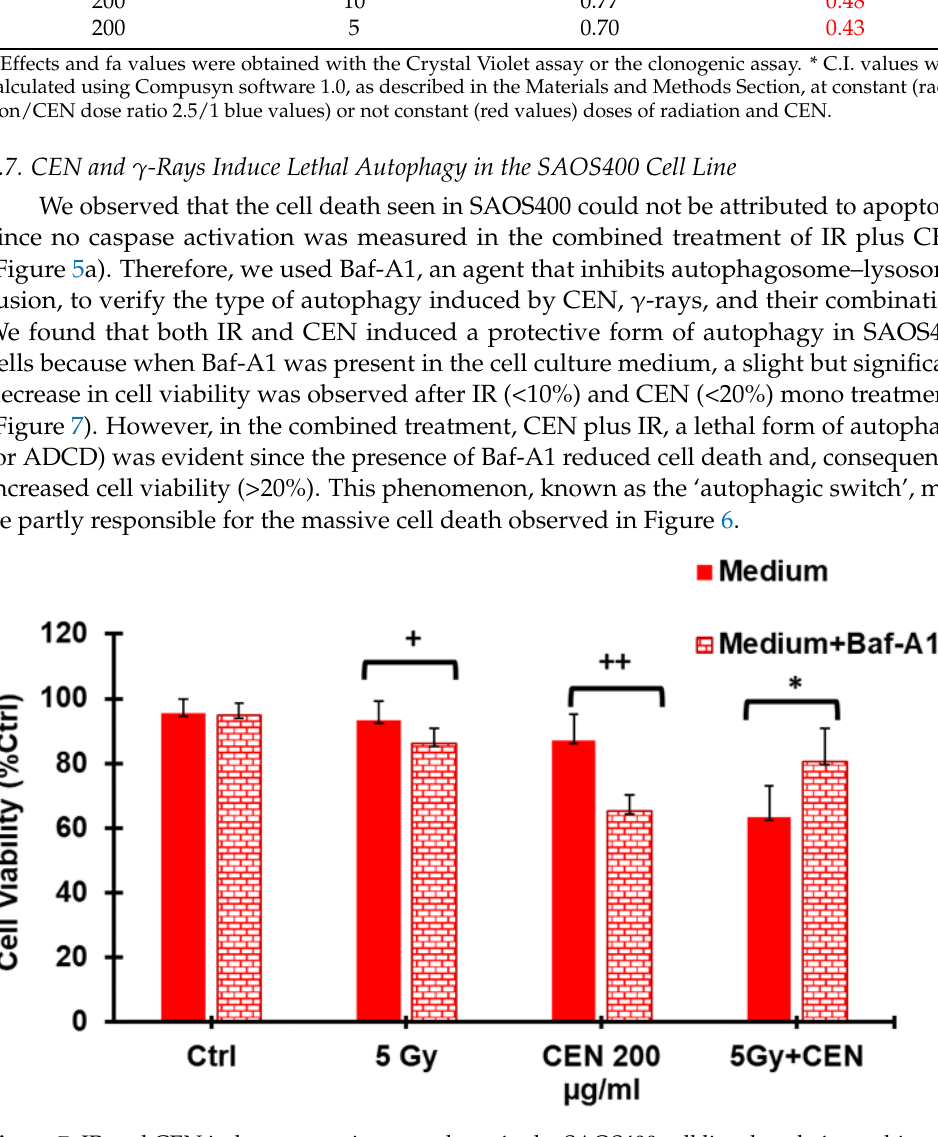
Table 1. Calculation of C.I. in the combined treatment of CEN plus IR. Figure 6. Irradiation and CEN synergistically induce cell death in the SAOS400 cell line. Panel ( a ): Cristal Violet Assay Crystal Violet assay in SAOS400 irradiated with 2.5 or 5 Gy and treated for 120 h with 100 or 200 μg/mL of CEN or their combination. The bar graphs represent the mean ± SD, and symbols and the linear bar indicate significance: +++ p < 0.001 Veh vs. IR- or CEN-treated cells, *** p < 0.001 CEN + IR vs. single treatments, Student’s t test. ( b ) Micrographs (200× magnification) of representative fields of SAOS400 cells treated as described in ( a ) and subsequently fixed and stained with Crystal Violet. Panel ( c ): Clonogenic assay. SAOS400 cells were irradiated with 2.5 or 5 Gy or incubated with 100 – 200 μg/mL of CEN and their combination for 11 days. Bar graphs represent the mean of the surviv- ing fraction (SF) ± SD; in other words, the colonies that survived after each treatment (CEN, radia- tion, or combinations) with respect to untreated cells considering the plating efficiency in the clon- ogenic assay, as explained in the Methods Section. Symbols indicate significance: *** p < 0.001 CEN + IR vs. single treatments, Student’s t test. Panel ( d ): Micrographs (100× magnification) of repre- sentative clones of SAOS400 cells treated as described in panel ( c ) and subsequently fixed and stained with Crystal Violet . Panel ( e ): Isobologram that reproduces the calculation of the combina- tion index (C.I., blue circle). The affected fractions (fa) were calculated based on the results obtained from the Crystal Violet assay using constant concentrations (radiation/CEN dose ratio 2.5/1). Panel § Effects and fa values were obtained with the Crystal Violet assay or the clonogenic assay. * C.I. values were calculated using Compusyn software 1.0, as described in the Materials and Methods Section, at constant (radia- tion/CEN dose ratio 2.5/1 blue values) or not constant (red values) doses of radiation and CEN.